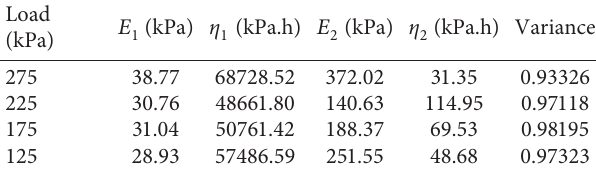
Table 3: Parameters of the Burgers